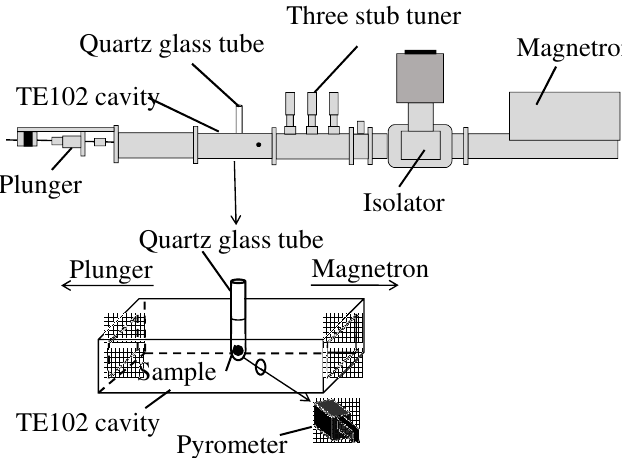
Figure 1. Schematic view of the microwave irradiation device and the sample setting of microwave irradiation at the maximum point of H-field